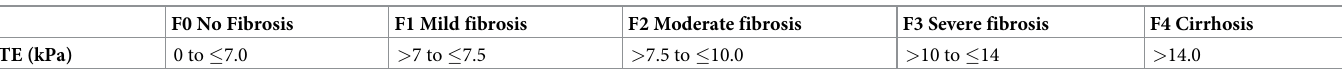
Table 1. Transient elastography (TE) scores.